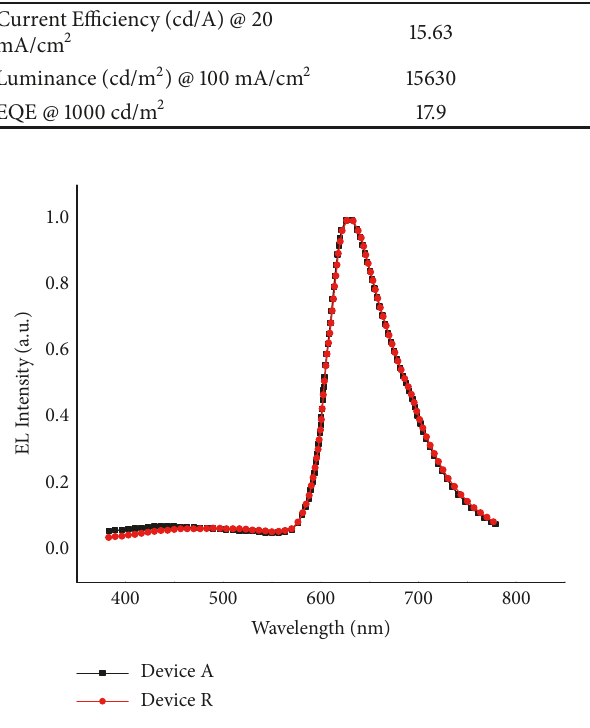
Figure 9: EL spectra of devices A and R.